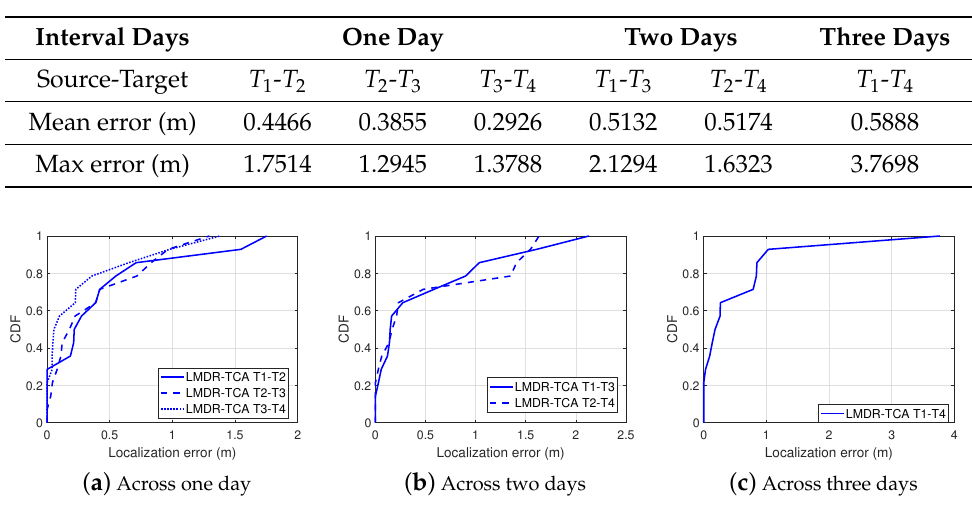
Figure 20. Cumulative distribution function of localization errors in the